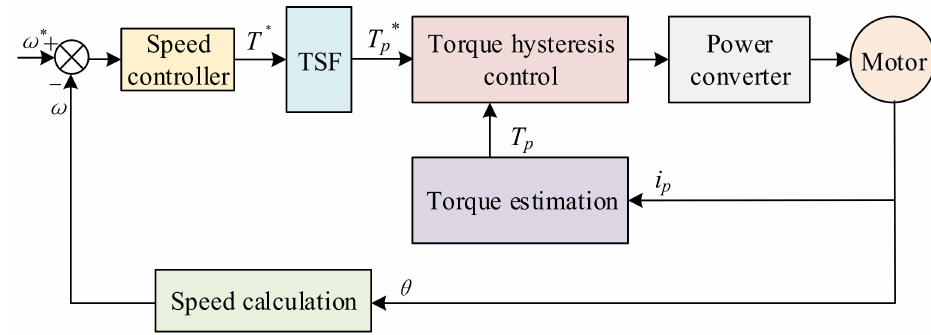
Figure 2. The TSF control block